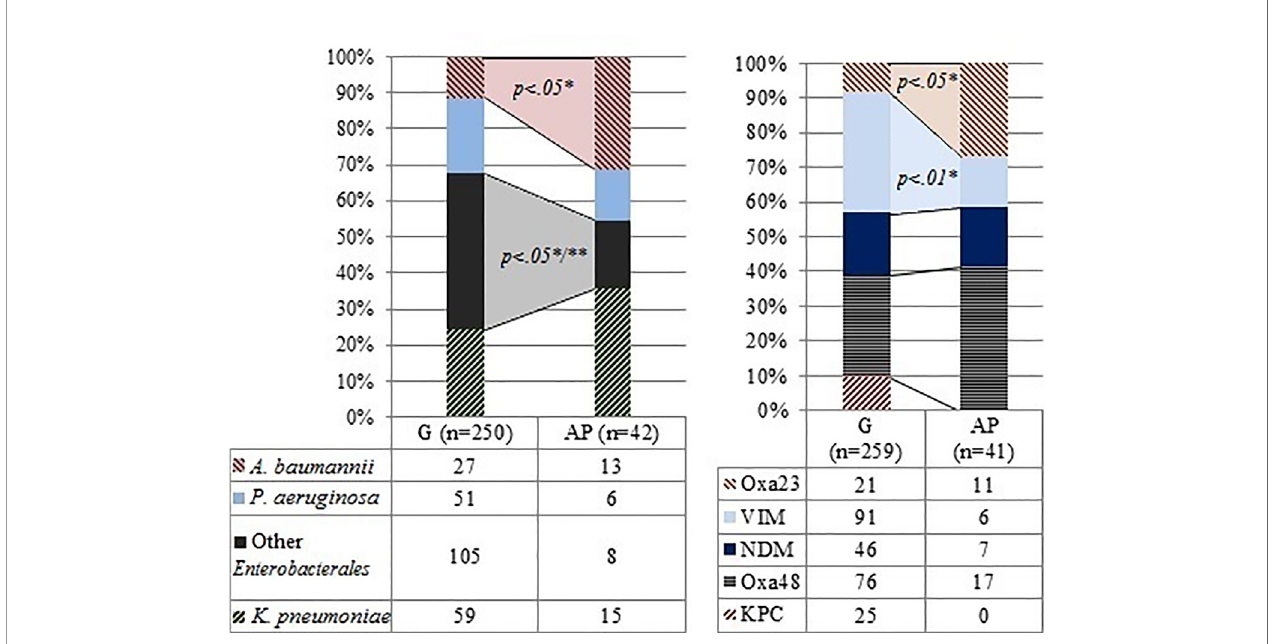
FIGURE 2 | Species and carbapenemases patients resident in Germany (G) and on the Arabian Peninsula (AP) were detected with. *P-values refer to the signi fi cance of the point estimates in the regression analysis (see Appendix B ). **P-value refers to Enterobacter isolates.